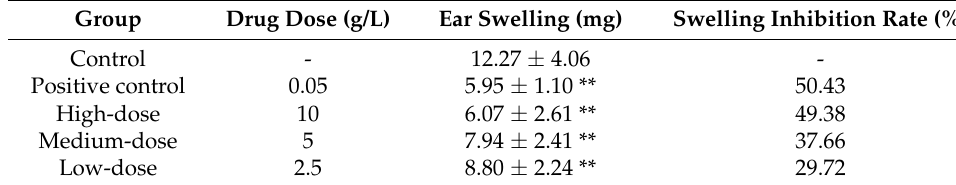
Table 3. Effect OFP on mice ear-swelling response.